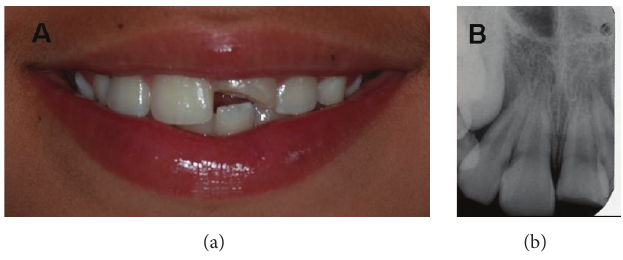
Figure 1: (a) Initial clinical aspect. (b) Initial radiographic aspect.